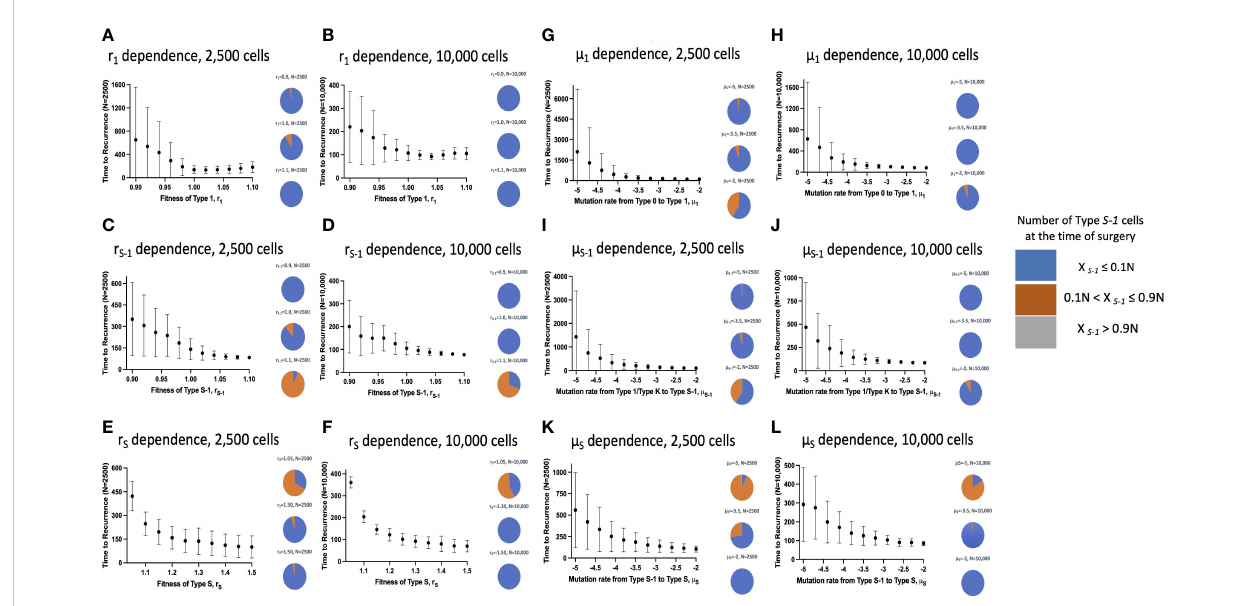
FIGURE 5 Parameter dependence on recurrence time with spatial structure. Simulation results with spatial structure are shown. Mean values obtained from 100 to 1,000 simulations are shown by dots, and standard deviations are indicated by bars. Pie charts in the panels indicate the proportion of Type S -1 cells in a normal tissue at the time of fi rst treatment. Blue, orange and grey represent small ( X S large ( X S -1 > 0.9 N ) proportion of Type S -1 cells, respectively. Standard parameter values used in (A – L) are d = d s =1.0, r 0 = 1.0, r 1 = 1.0, r S -1 = 1.2, r S = 1.0, m 1 = 0.001, m S -1 = 0.001, m S = 0.001; and N = 2,500 in (A, C, E, G, I, K) ; and N = 10,000 in (B, D, F, H, J, L)